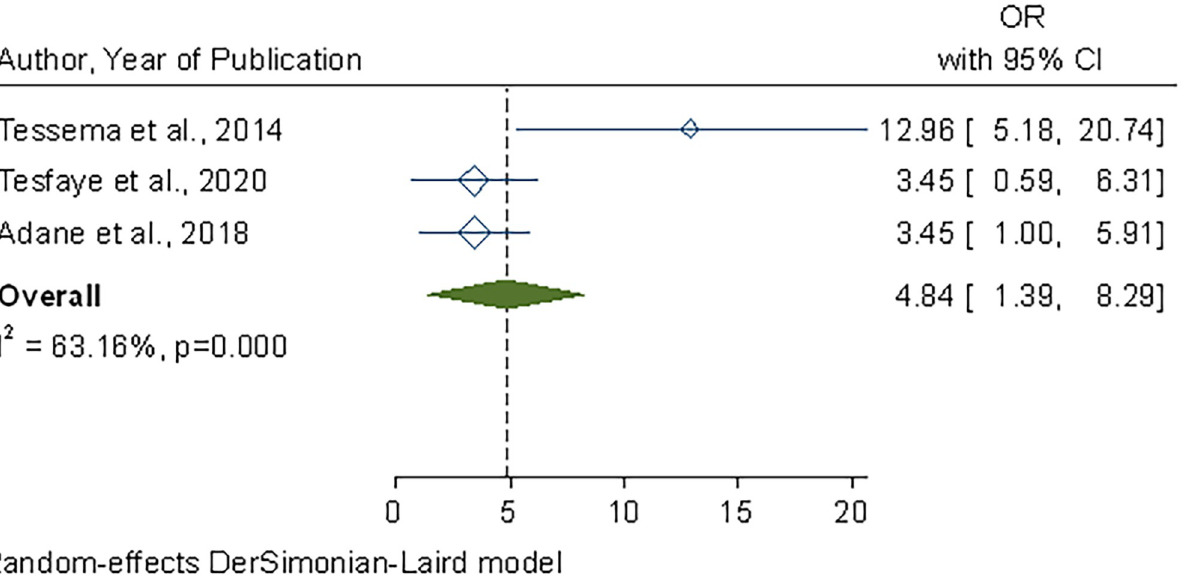
Fig 8. Forest plot of the association between attitude and safe food handling practices in Ethiopia, 2022.